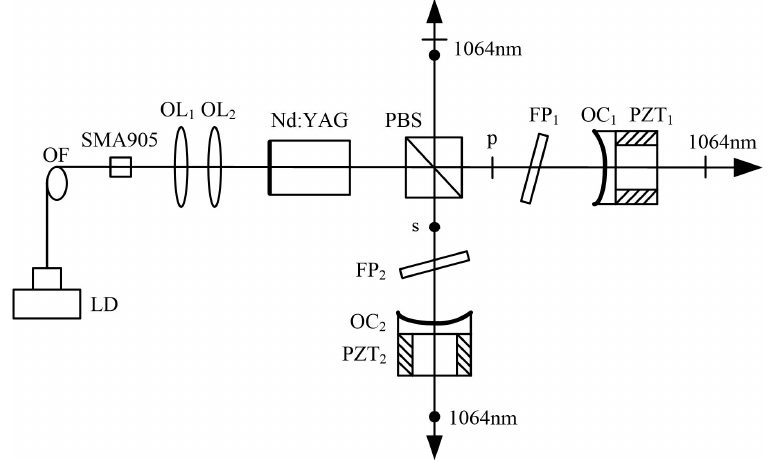
Figure 35. Schematic of TCDFL based on the principle of longitudinal-mode selection by single F-P etalon [40]. LD: laser diode; OF: optical fiber; SMA905: OF connector; OL: optical lens; PBS: polarizing beam splitter; FP: F-P etalon; OC: output coupler; PZT: piezoelectric transducer.